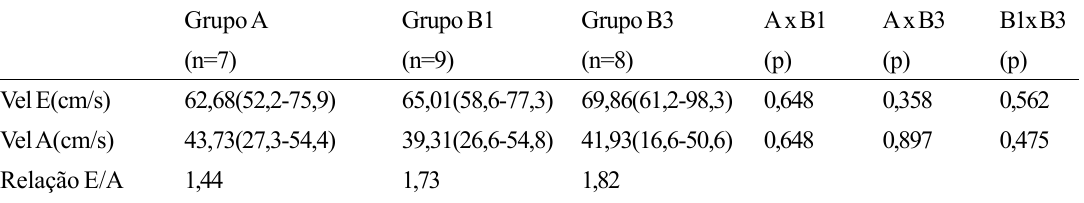
Tabela 1. Análise dos parâmetros ecocardiográficos aferidos ao Doppler transmitral no grupo controle (A) e nos animais